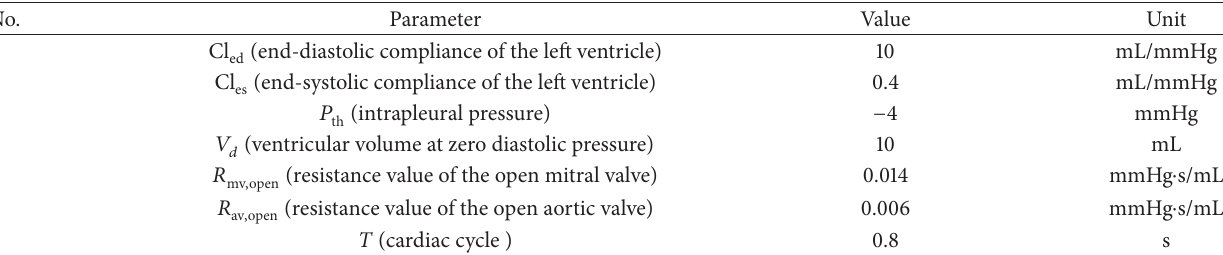
Table 2: Values of the parameters used in the heart model and the cardiac valve model